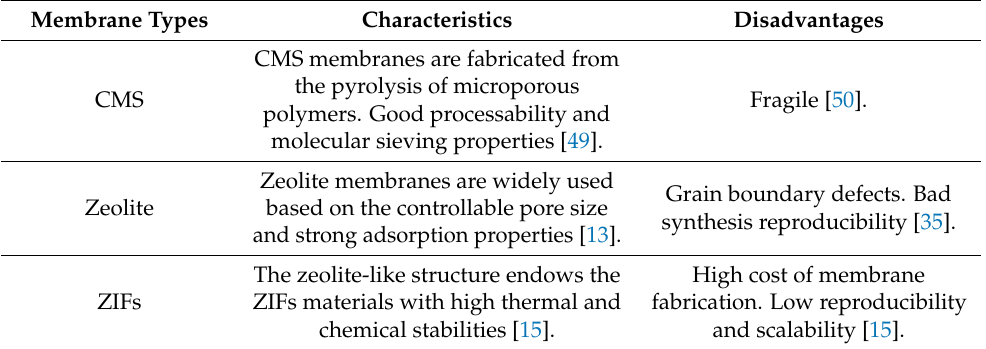
Fragile [50]. Grain boundary defects. Bad synthesis reproducibility [35]. High cost of membrane fabrication. Low reproducibility and scalability